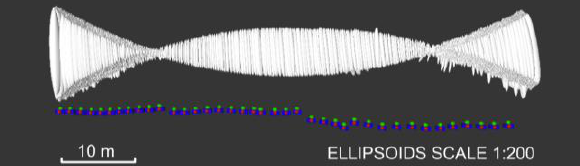
Figure 4: 3D points’ uncertainty displayed with the error ellipsoids for the normal geometry free network (version A).